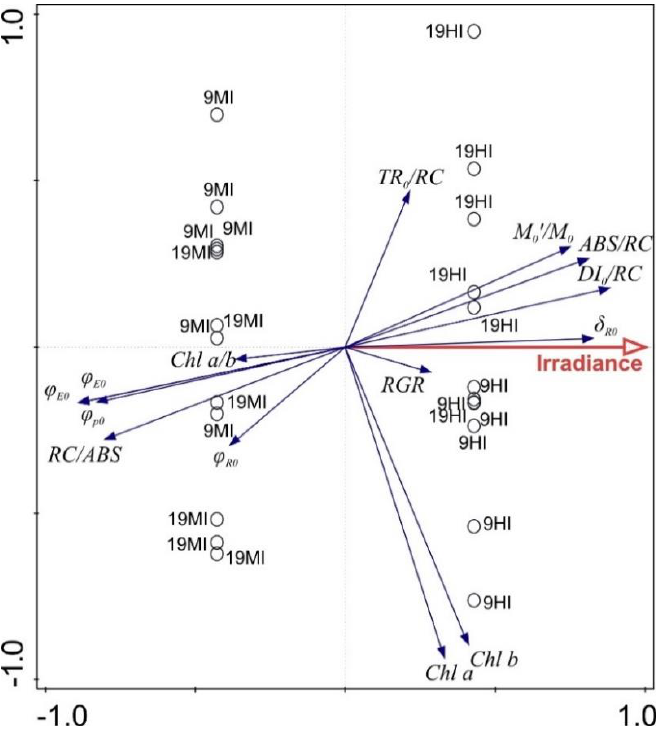
Figure 7. Triplot from the redundancy analysis (RDA) that shows the relationships between the JIP-test parameters, chlorophyll content and relative growth rate (RGR) parameters of Stuckenia pectinata . The length of the arrows indicates the strength of representation and contribution of each parameter to the PC axes. MI = moderate irradiance, HI = high irradiance, 9 and 19 correspond to salinity values. For further information, see Tables 1 and 2. The first axis accounted for 44.2% of the variation, while the second axis accounted for